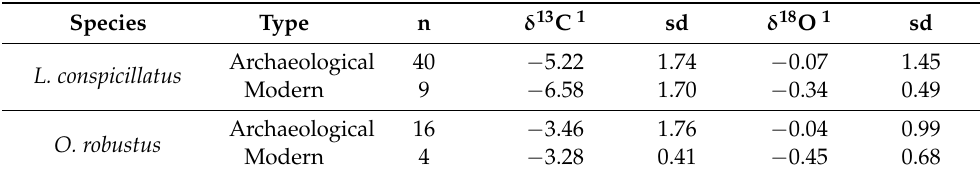
Table 1. Mean stable carbon and oxygen data for modern and archaeological L. conspicillatus and 2 O. robustus tooth enamel carbonates.